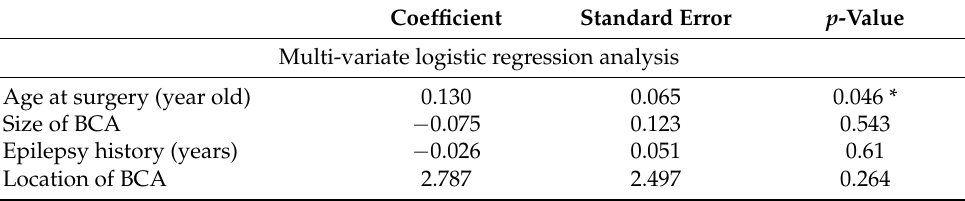
Table 3. Statistical analyses of predictors for ILAE class I without epileptiform on scalp EEG. Coefficient Standard Error p -Value Multi-variate logistic regression